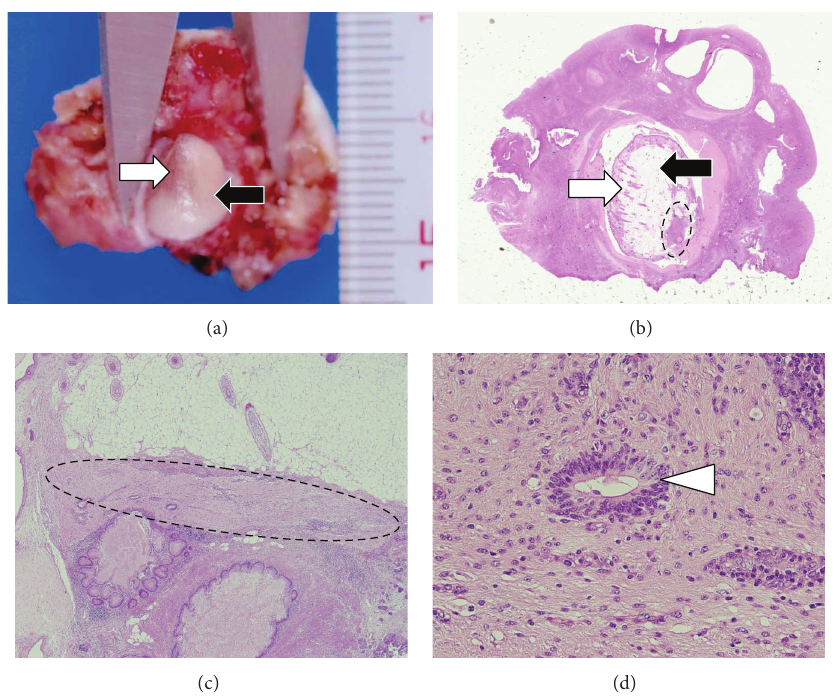
Figure 3: Pathological findings in the partially resected right ovary. (a) Gross appearance of the partially resected right ovary. There is a mature cystic teratoma in the ovary, measuring 5 by 7mm. The open arrow indicates hair, and the closed arrow indicates fat. ((b), (c)) Low- power views of the histologic section of the mature cystic teratoma. The open arrow indicates hair, and the closed arrow indicates fat. The area circled by broken lines indicates brain tissue in the mature cystic teratoma ((b) H.E., × 1; (c) H.E., × 10). (d) High-power view of the mature cystic teratoma showing brain tissue. The open arrow head indicates a central canal-like structure (H.E., ×